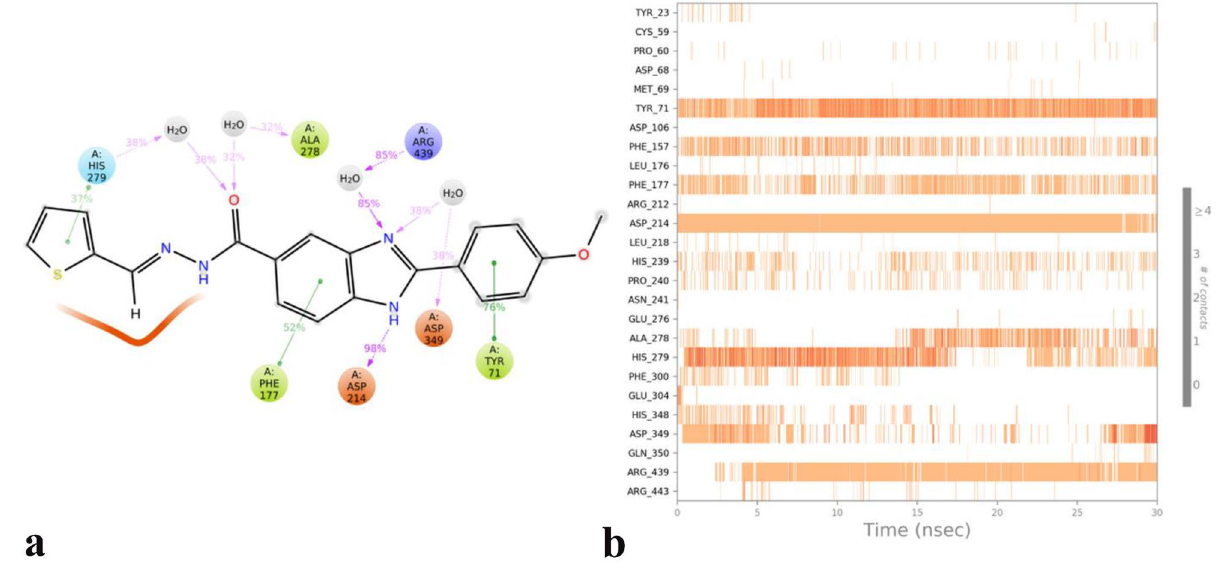
Figure 5. The timeline representation of the interactions shows the residues interact with compound 8p in each trajectory frame (more than one specific contact with the ligand is represented by a darker shade of orange) ( a ). The simulation interactions diagram panel in which the stacked bar charts are normalized over the course of the trajectory: some protein residues may make multiple contacts with the ligand ( b ) (Desmond v5.3).